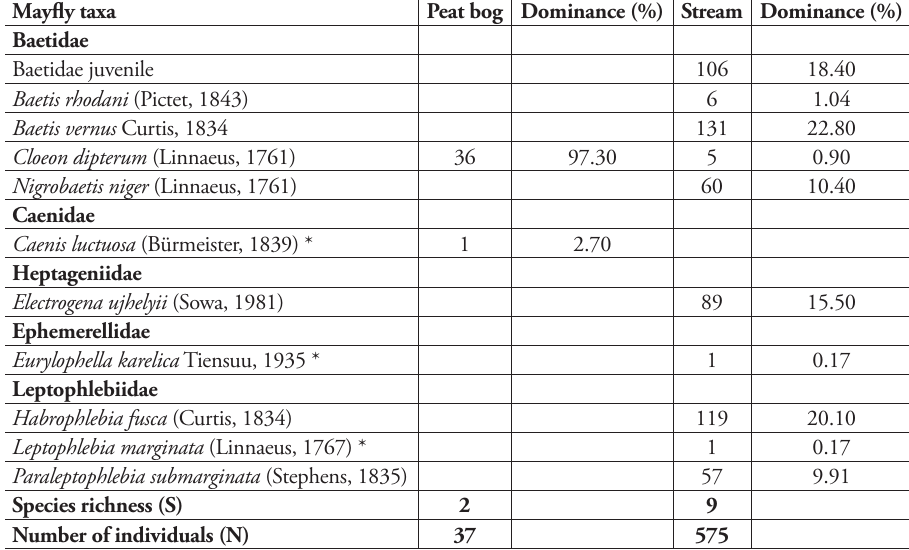
Table 2. Mayfly taxa and their abundance recorded in the Đon močvar peat bog and adjacent stream. Key: * new mayfly records for the Croatian